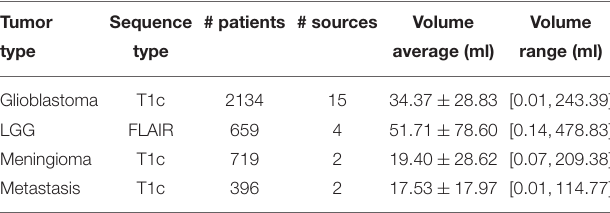
TABLE 1 | Overview of the datasets gathered for the four brain tumor types considered. Tumor Sequence # patients #